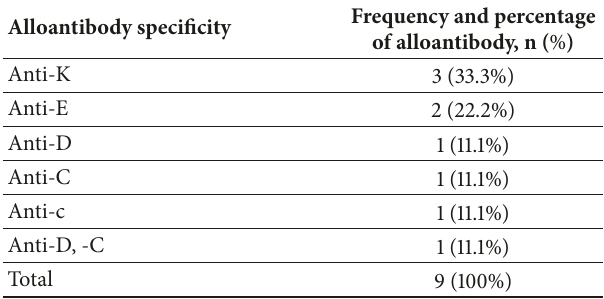
Table 2: Alloantibody specificity and frequency in 116 Palestinian SCD